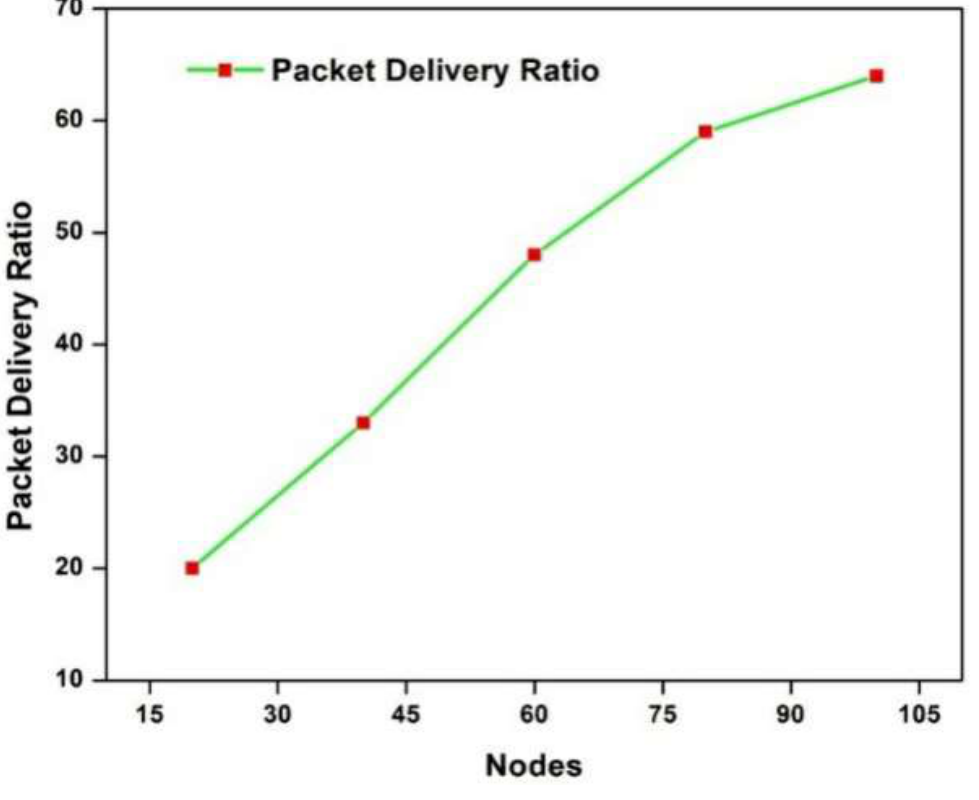
Figure 14. Ratio of packet delivery.